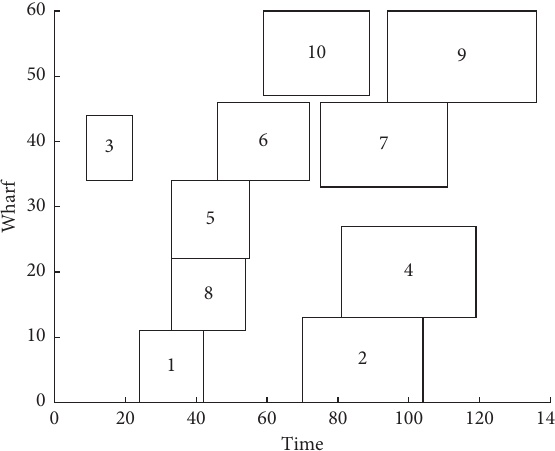
Figure 2: The baseline berth plan of the example instance. Figure